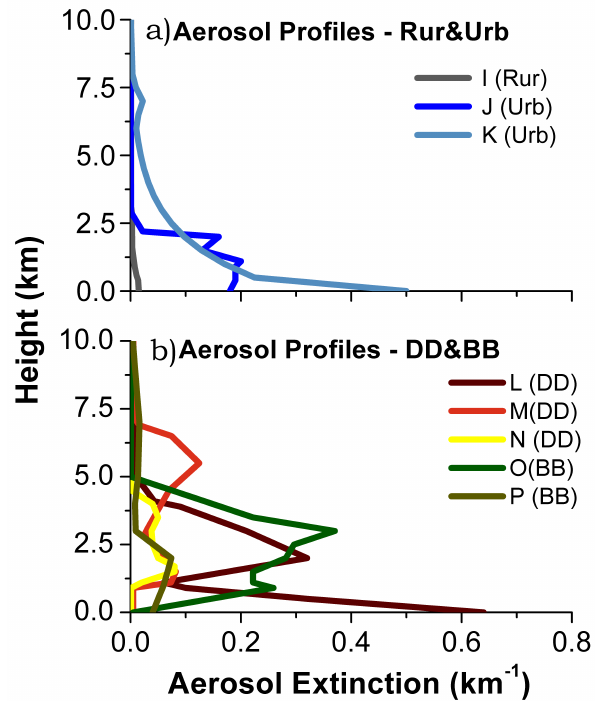
Fig. 4. Aerosol extinction profiles from surface level to 10.0km used in the SCIATRAN settings for the airmass factor calculations for: (a) rural (Rur) and urban (Urb) locations; and (b) desert dust (DD) events and biomass burning (BB) plumes. These profiles are based on measurements performed at different locations as it is ex- plained in Table